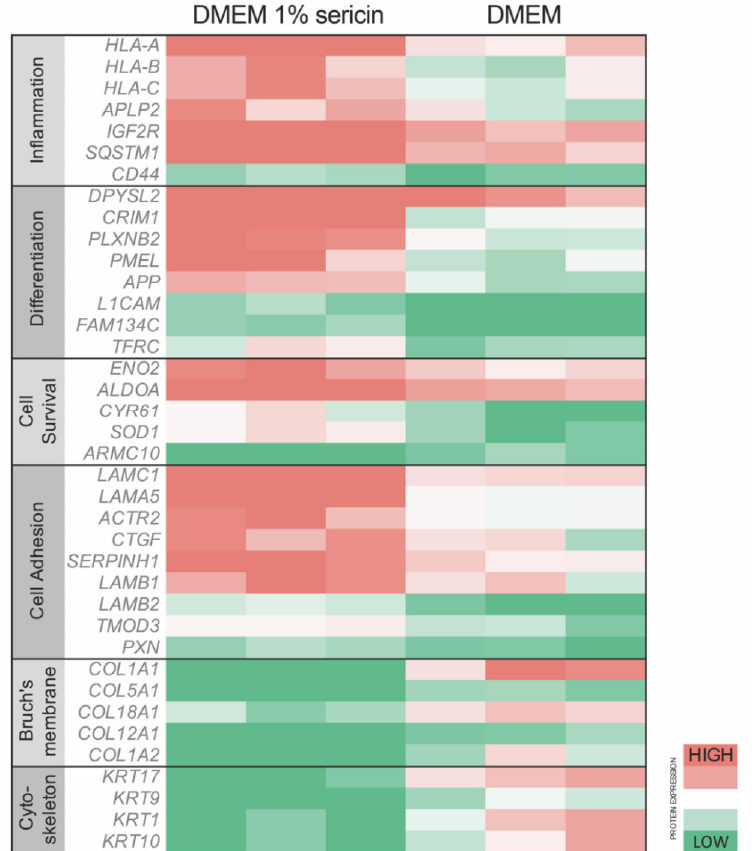
Figure 2. Primary human fetal retinal pigment epithelial cells (RPE) were cultured in Dulbecco’s Modified Eagle’s Medium (DMEM) with or without 1% sericin. All cultures were subjected